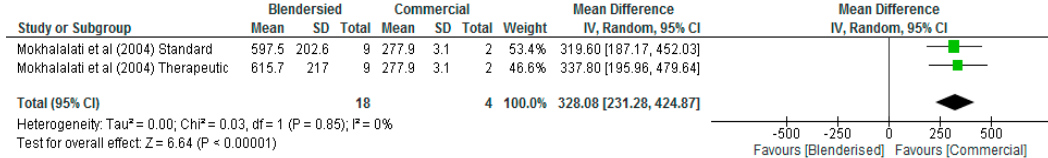
Figure 11: Shows osmolality of blenderised and commercial ENF (mOsm/kg H 2